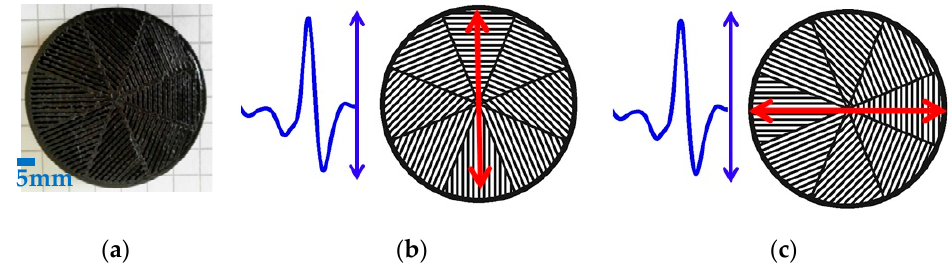
Figure 3. ( a ): Picture of the manufactured q-plate realized using ABS and 3D printing technology. ( b , c ): Sketch showing the orientation of the impinging E-field (blue arrow) with respect to the main axis (red arrow) of the q-plate to achieve radial and azimuthal polarization distributions, respectively.